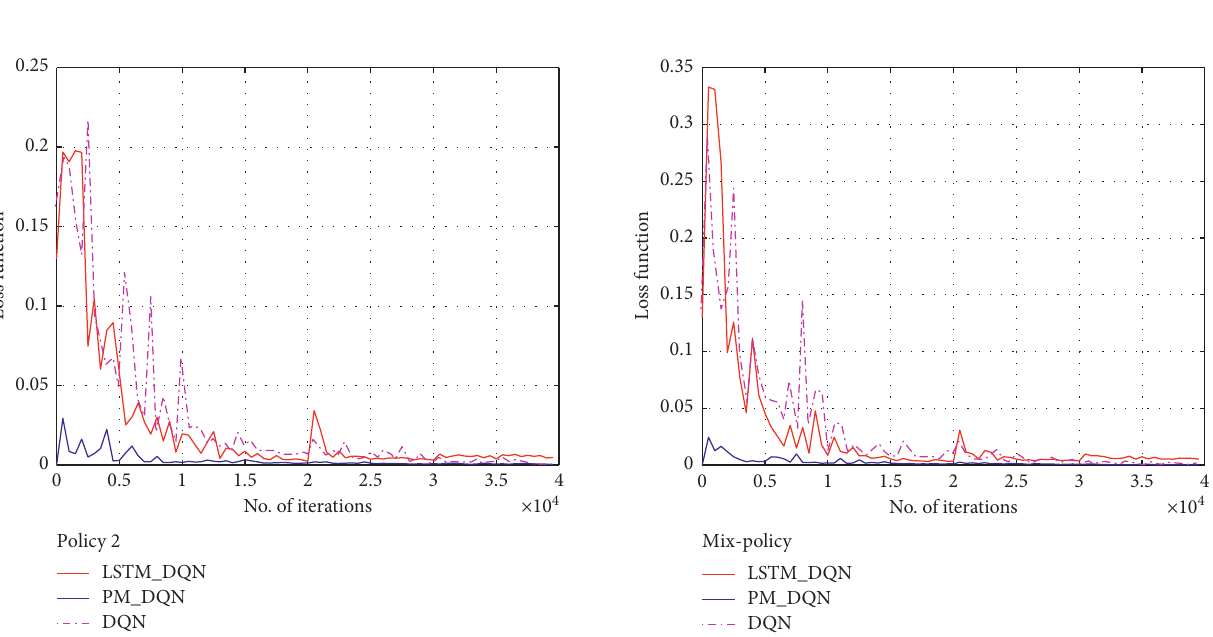
Figure 5: Relationship between the number of iterations and loss function (policy 2).